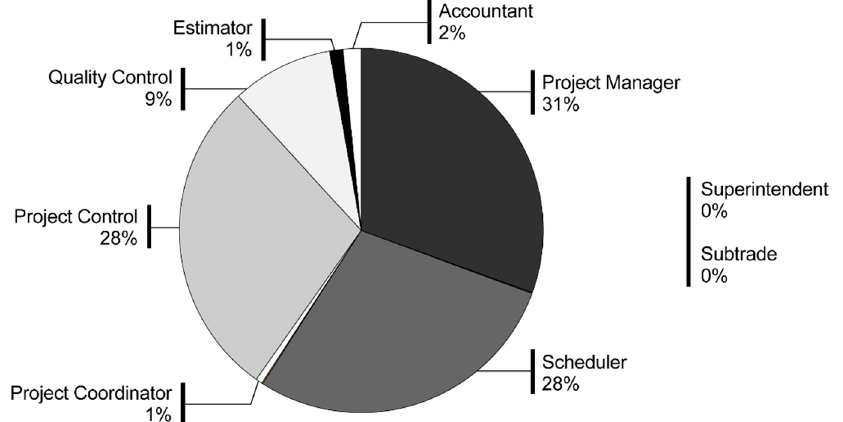
Figure 13. Distribution of report preparation time between personnel types.